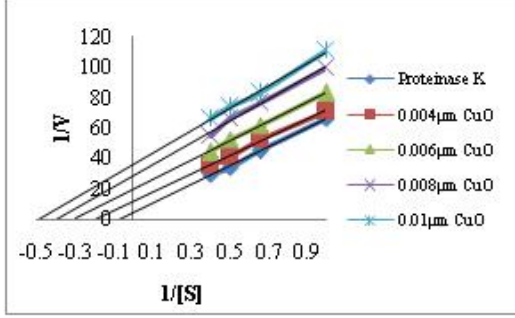
Fig. 4 . Lineweaver-Burk plot of proteinase K